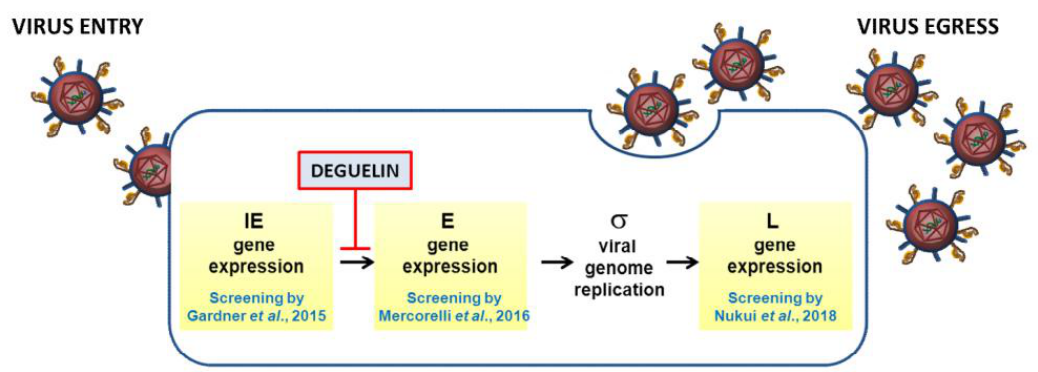
Figure 1. Different stages of the HCMV replication cycle targeted by drug repurposing campaigns. The schematic depicts the sequential steps of the HCMV gene expression cascade that have been targeted by the three indicated screening studies (IE, Immediate Early; E, Early; σ , sigma (stands for DNA replication by the rolling circle mechanism; L, Late). Deguelin is a flavonoid selected in the screenings by Mercorelli et al. [8] and Nukui et al. [9] and further characterized for its anti-cytomegaloviral activity and the ability to inhibit the expression of viral E genes.